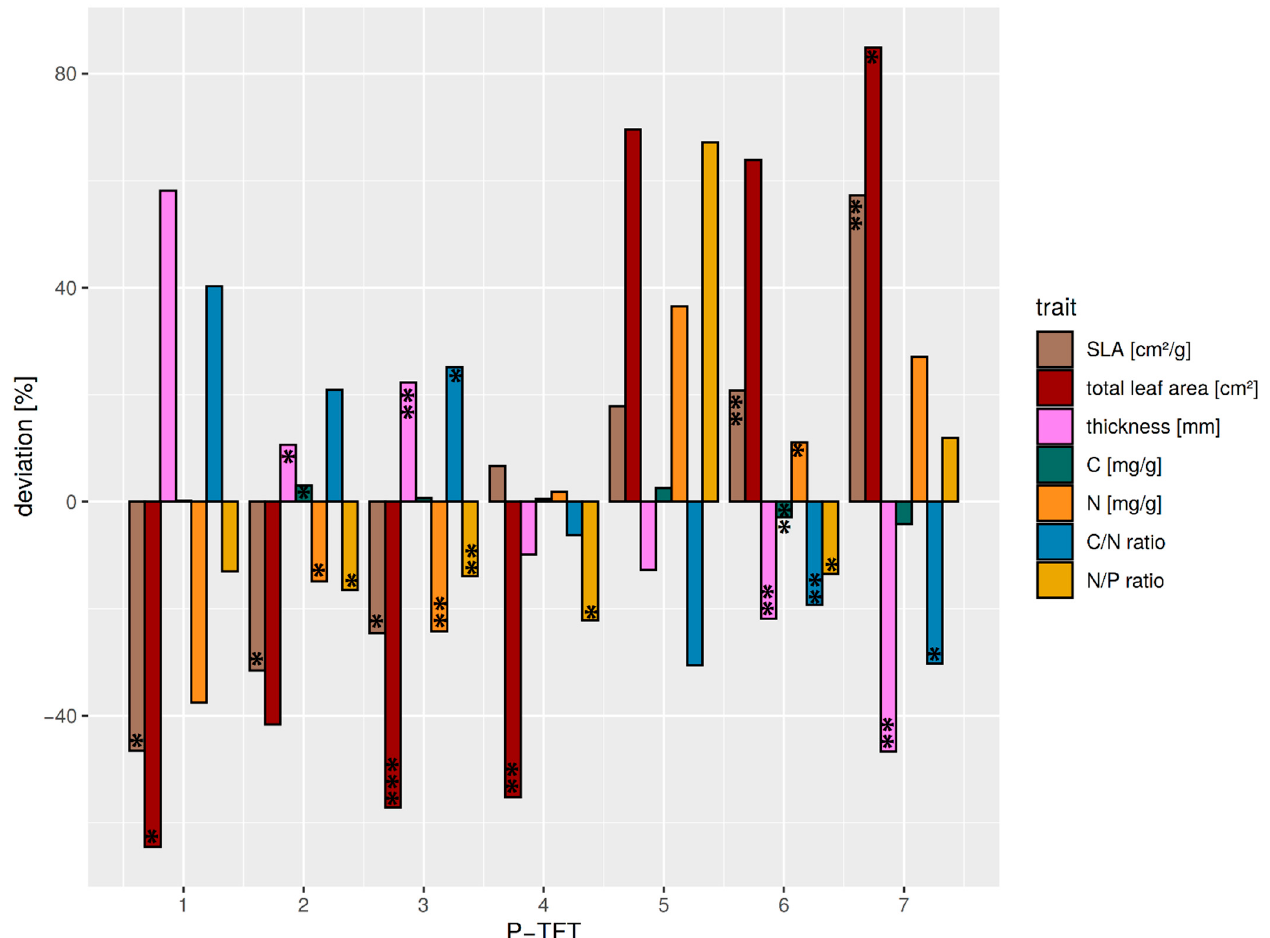
Figure 4. Relative deviation from the average median of dominating functional traits (relation > 0.5 with the OFIs F1 and F2) relevant to productivity for all P-TFTs. Average median values over all P-TFTs are: SLA = 81.5 cm 2 /g, leaf thickness = 0.32 mm, C = 478.9 mg/g, N = 17.3 mg/g, N/C = 29.7, and N/P = 20.2. Significant differences between the TFT traits and the average TFT median trait are marked corresponding to the p -value < 0.05: *; p -value < 0.01: **; p -value < 0.001: ***. The P-TFT 5 was not tested, as it was only comprised of a single species.